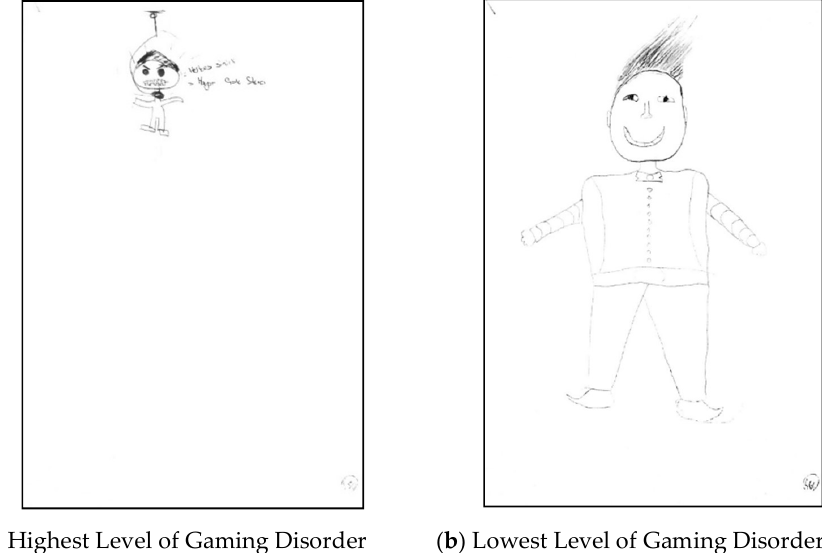
Figure 3. These pictures show the Draw-a-Person test drawings of two children with the highest and lowest scores on the DGAS. ( a ) The child who drew the picture is 13 years old. He scored 25 points from the DGAS (max. 28–min. 0), 19 points on CNS (max. 30–min. 0), and 33 points (max. 120–min. 30) on SCHI. ( b ) The child who drew the picture is 12 years old. He scored 0 points on the DGAS, 30 points on CNS, and 119 points on SCHI.